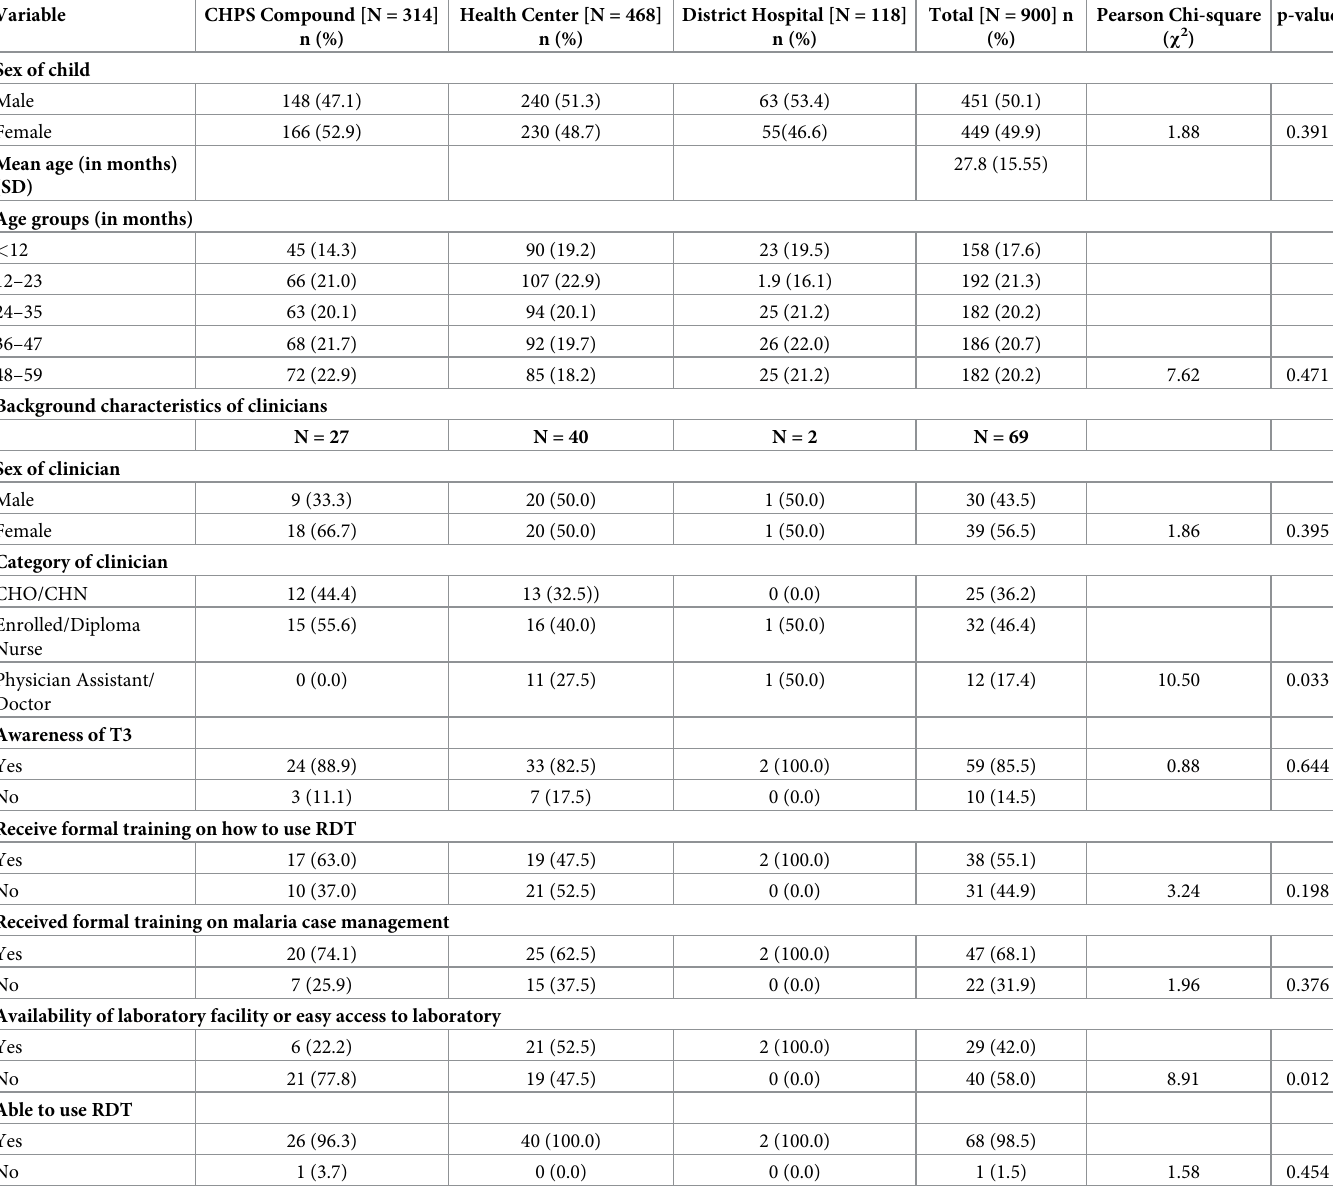
Table 1. Distribution of background characteristics of children under 5 years and clinicians by level of health